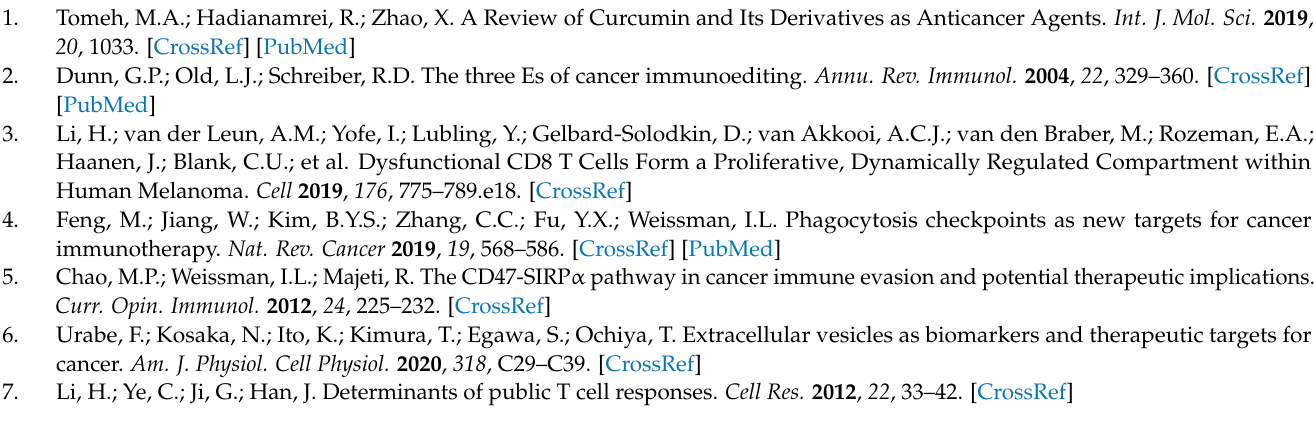
Table S1: The information on the results of HR, FC, Correlation and Prognosis of individual or paired genes; Table S2: Patients’ risk scores calculated for gene pairs based on the risk score